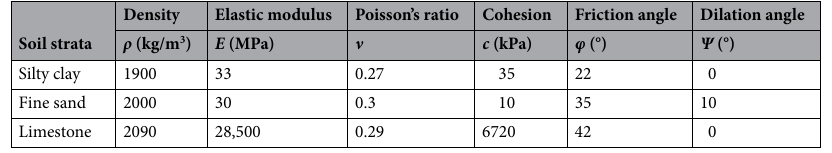
Table 1. Physical parameters of soil strata.